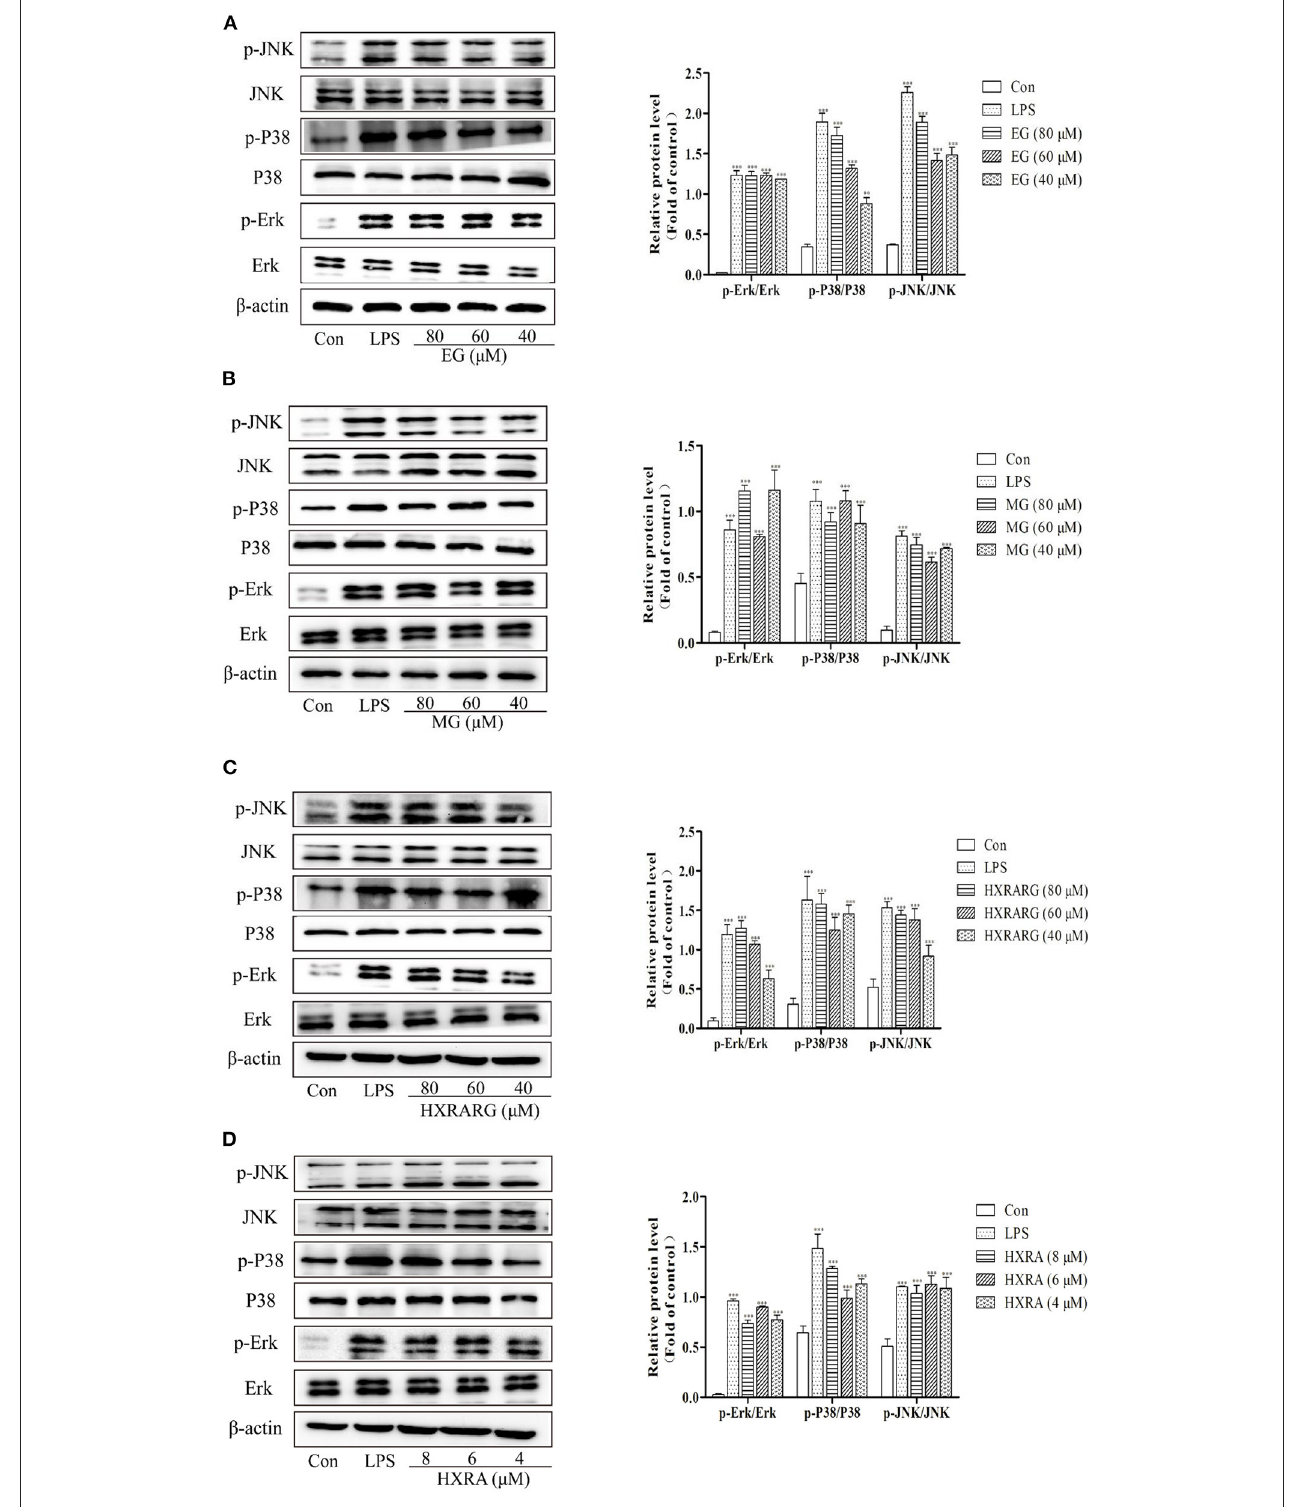
FIGURE 9 | Effects of different concentrations of EG (A) , MG (B) , HXRARG (C) , and HXRA (D) on the expression of related proteins in MAPK signaling pathway in RAW264.7 cells. The left side was the protein band diagram, and the right side was the protein quantification diagram. Data are expressed as the means ± SD. Compared with the control, *** P <